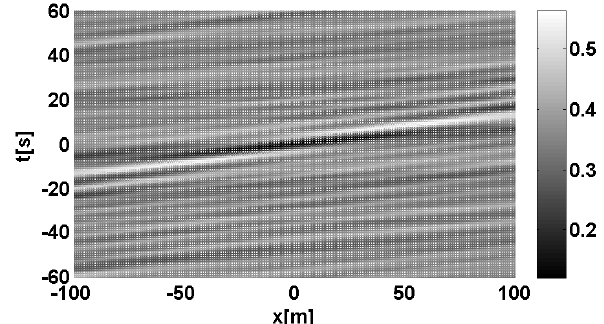
Fig. 15. The density plot of the variance of the total wave phase for the Draupner